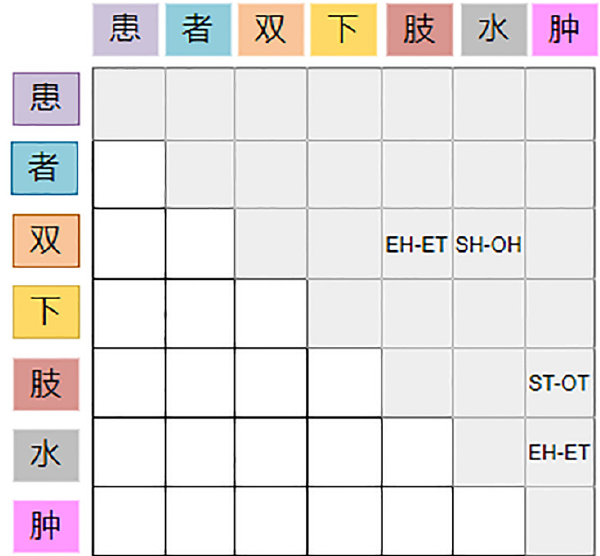
Figure 5. The marker matrix.